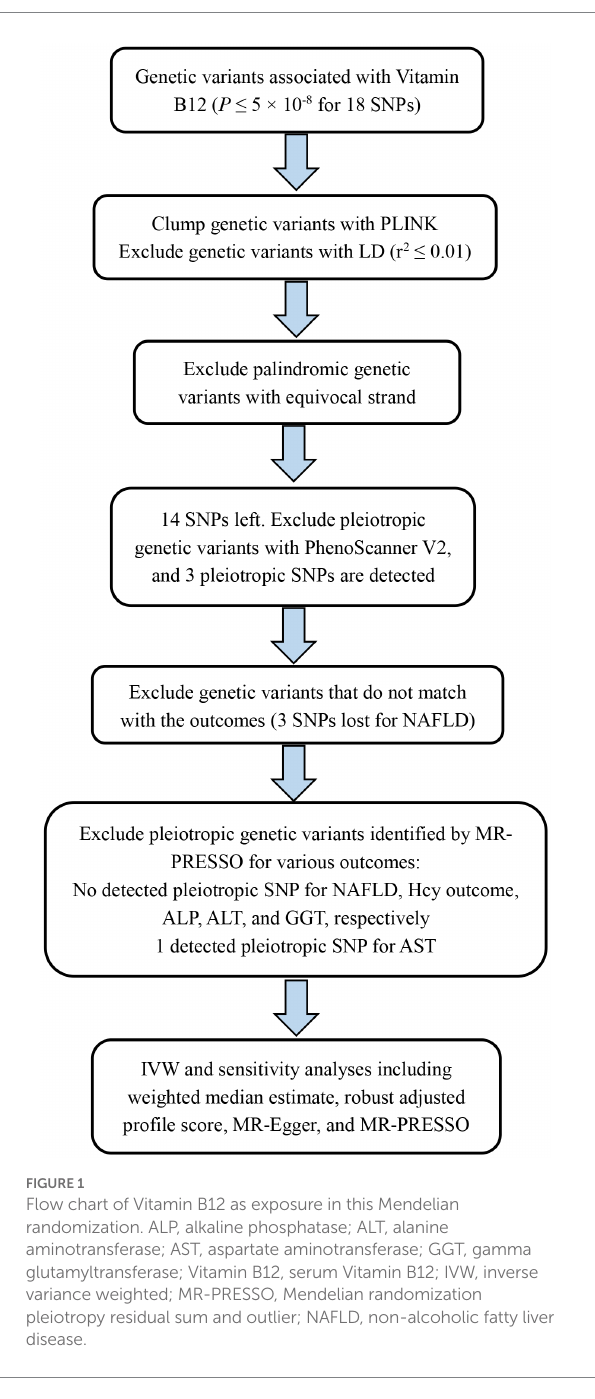
FIGURE 1 Flow chart of Vitamin B12 as exposure in this Mendelian randomization. ALP, alkaline phosphatase; ALT, alanine aminotransferase; AST, aspartate aminotransferase; GGT, gamma glutamyltransferase; Vitamin B12, serum Vitamin B12; IVW, inverse variance weighted; MR-PRESSO, Mendelian randomization pleiotropy residual sum and outlier; NAFLD, non-alcoholic fatty liver